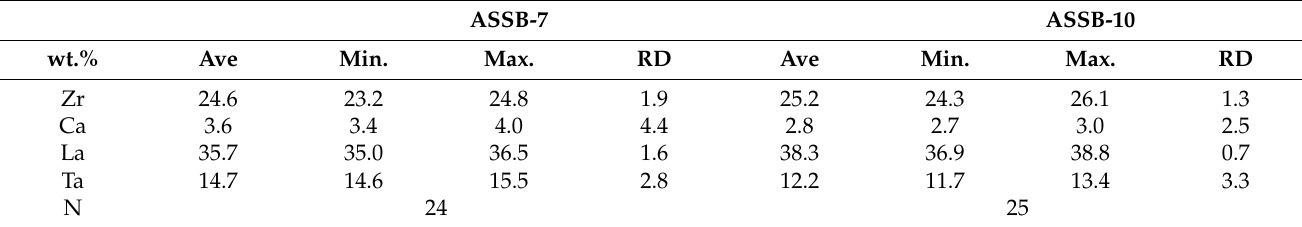
Table A8. Composition of PyC (wt.%) based on single-point analysis. Ave.: arithmetic average; Min./Max.: lowest/highest measured values; RD: relative standard deviation (%);N: number of